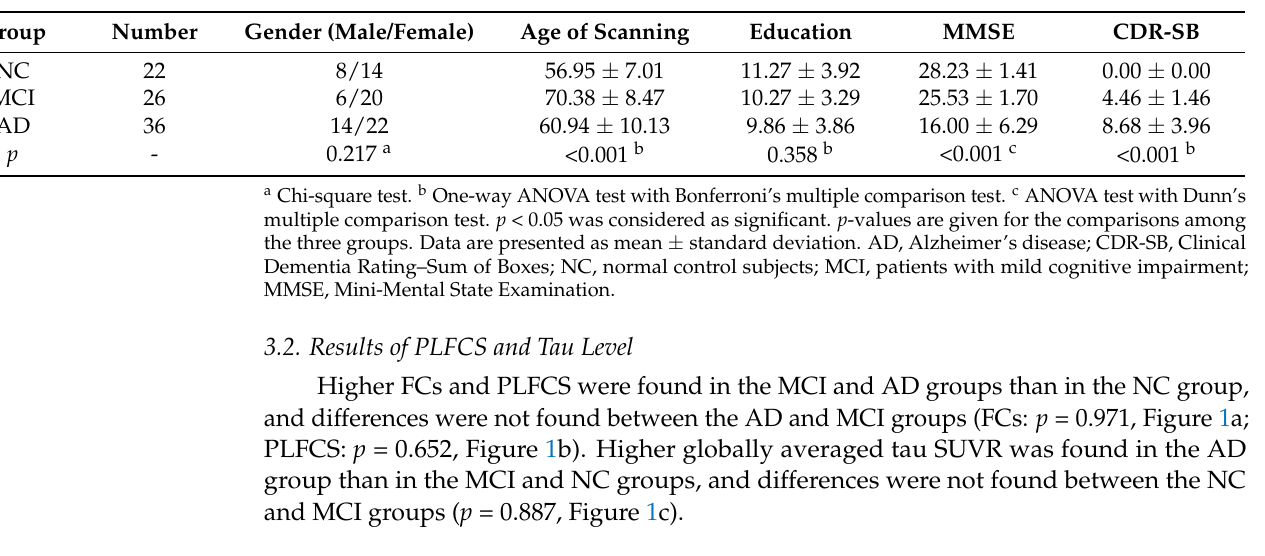
Table 1. Demographic information and scores of cognitive examinations.